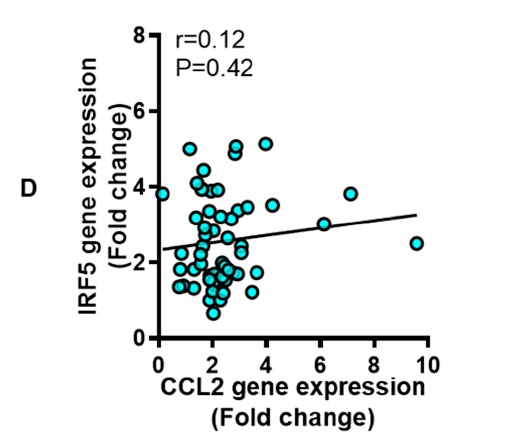
Figure 7. Increased adipose chemokine CC motif ligand-2 (CCL2) expression in obesity. CCL2 gene expression was determined in six lean, 18 overweight, and 23 obese non-diabetic individuals using real-time RT-PCR, while CCL2 protein expression was also assessed in six lean, 14 overweight, and 10 obese non-diabetic individuals using immunohistochemistry (IHC) as described in Materials and Methods. The data (mean ± SEM) show that ( A ) adipose CCL2 mRNA expression was upregulated in obese (P = 0.05) compared with lean subjects. ( B ) CCL2 protein expression (IHC intensity shown as arbitrary units) was also higher in overweight as well as obese individuals (P < 0.0001) as compared with lean. ( C ) The representative IHC images obtained from three independent determinations with similar results show elevated CCL2 adipose expression (cyan arrows, 100 × magnification) in overweight and obese as compared with lean individuals. Scale bar = 50 µ M. ( D ) There was no association found between IRF5 and CCL2 gene expression in the adipose tissue (r = 0.12, P = 0.42). The asterisks * and **** represent significance levels of P ≤ 0.05 and P < 0.0001,